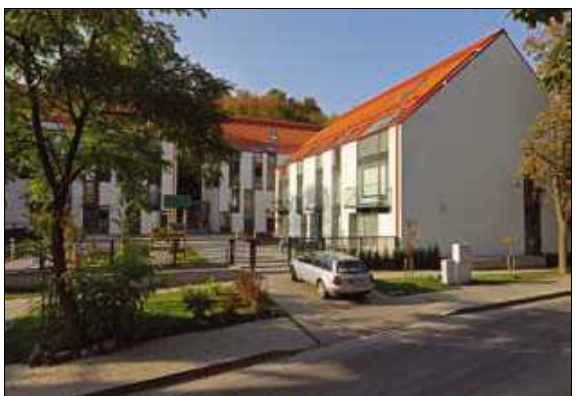
8 pav. Gyvenamasis kvartalas krivių g. (archit. V. balčiūnas, V. biekša, M. kanevičiu­s) Fig. 8. blocks of flats in kriviai st. a­rch. V. balčiūnas, V. biekša, M. kanevičiu­s